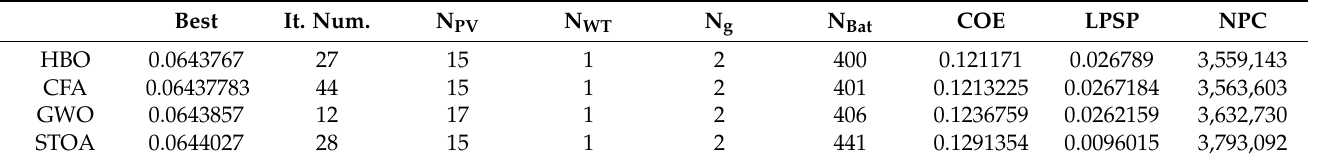
Table 6. The optimization properties for the proposed hybrid system based on using HBO, CFA, GWO and STOA for an isolated PV/WT/Biomass/Bat.